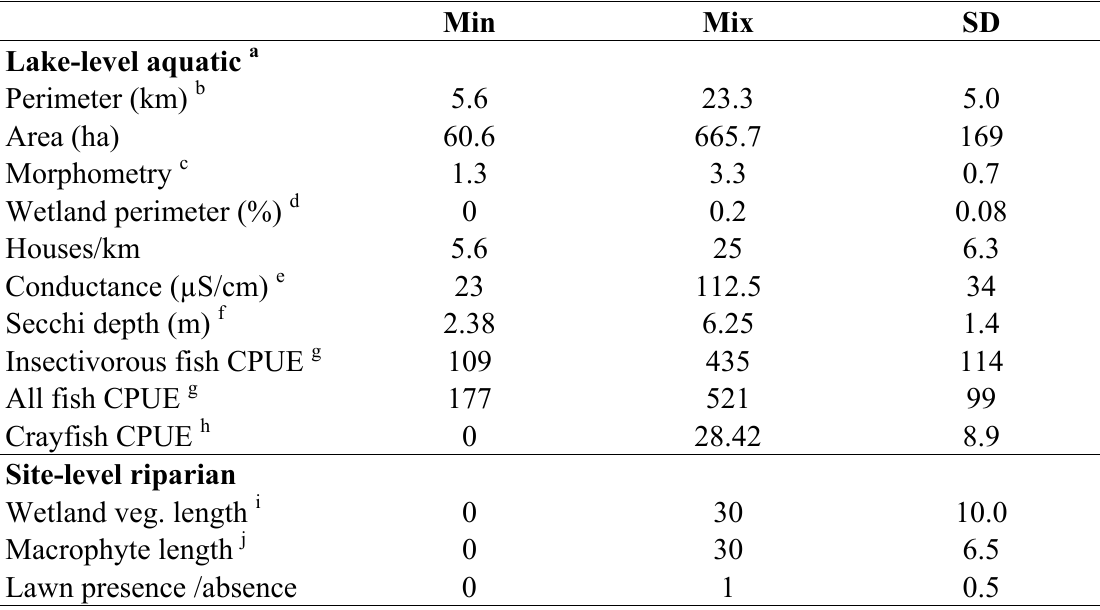
Table 1. Range and standard deviations in lake-level (n = 9) and site-level (n = 22) habitat variables tested as predictors for Gomphidae